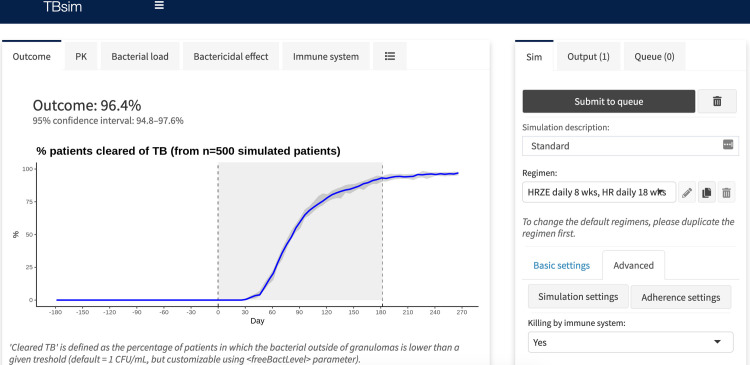
Screenshot of web application.Graphical user interface of the TBsim tool. User can adjust regimen, drug parameters, adherence, and immune and resistance inputs. Outputs include pharmacokinetic profiles, bacterial load in intra and extracellular compartments, and immune system plots.